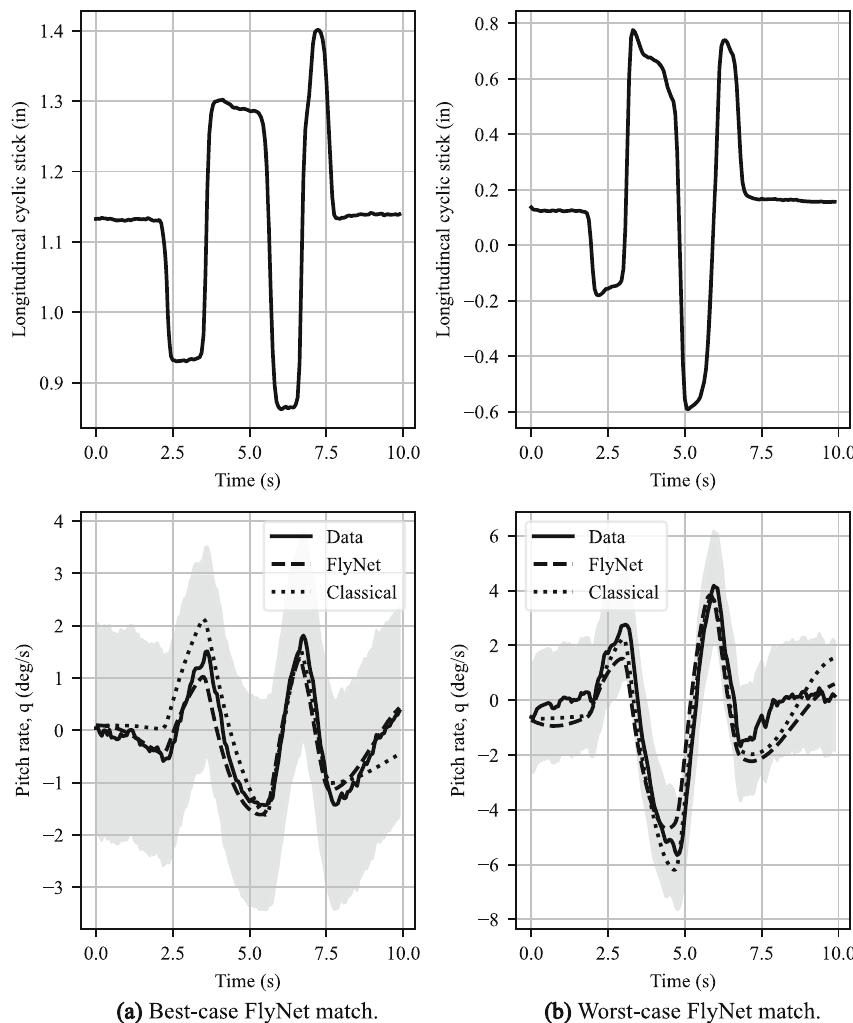
Fig. 6 Example pitch rate time history matches for FlyNet and classical models for a longitudinal stick 2-3-1-1 input in the training set. The gray area is the ± 2deg. s − 1 bounds set in [41] for full flight